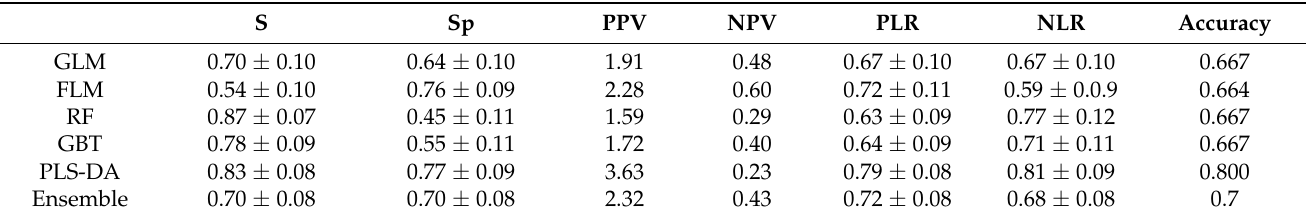
Table 3. Diagnostic performance of each classification model and of the ensemble. Results are expressed as value ± standard error.